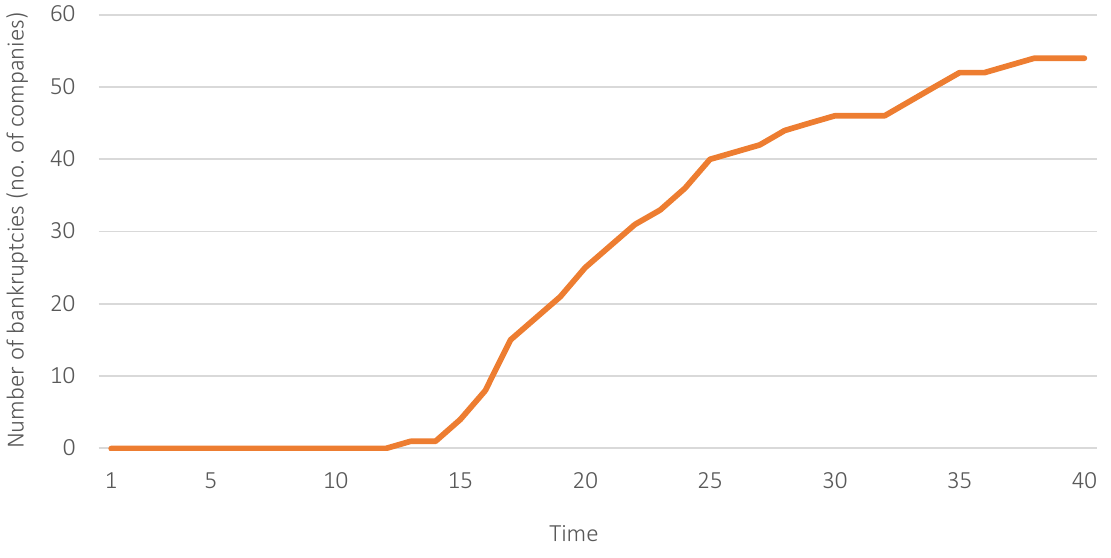
Figure 12. Evolution of the number of bankruptcies in a conventional LBO market (out of 500